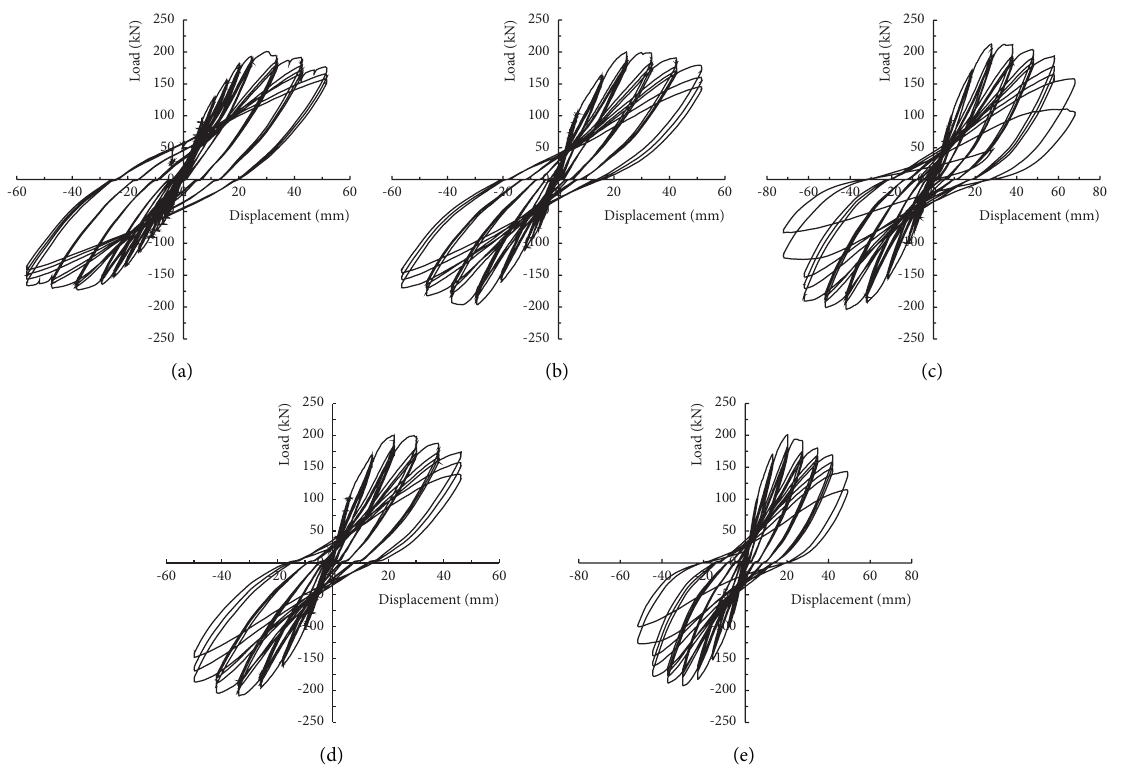
Figure 5: Hysteresis curves of specimens. (a) PTRC-1. (b) PURC-1. (c) PURC-2 and PURC-p3. (d)